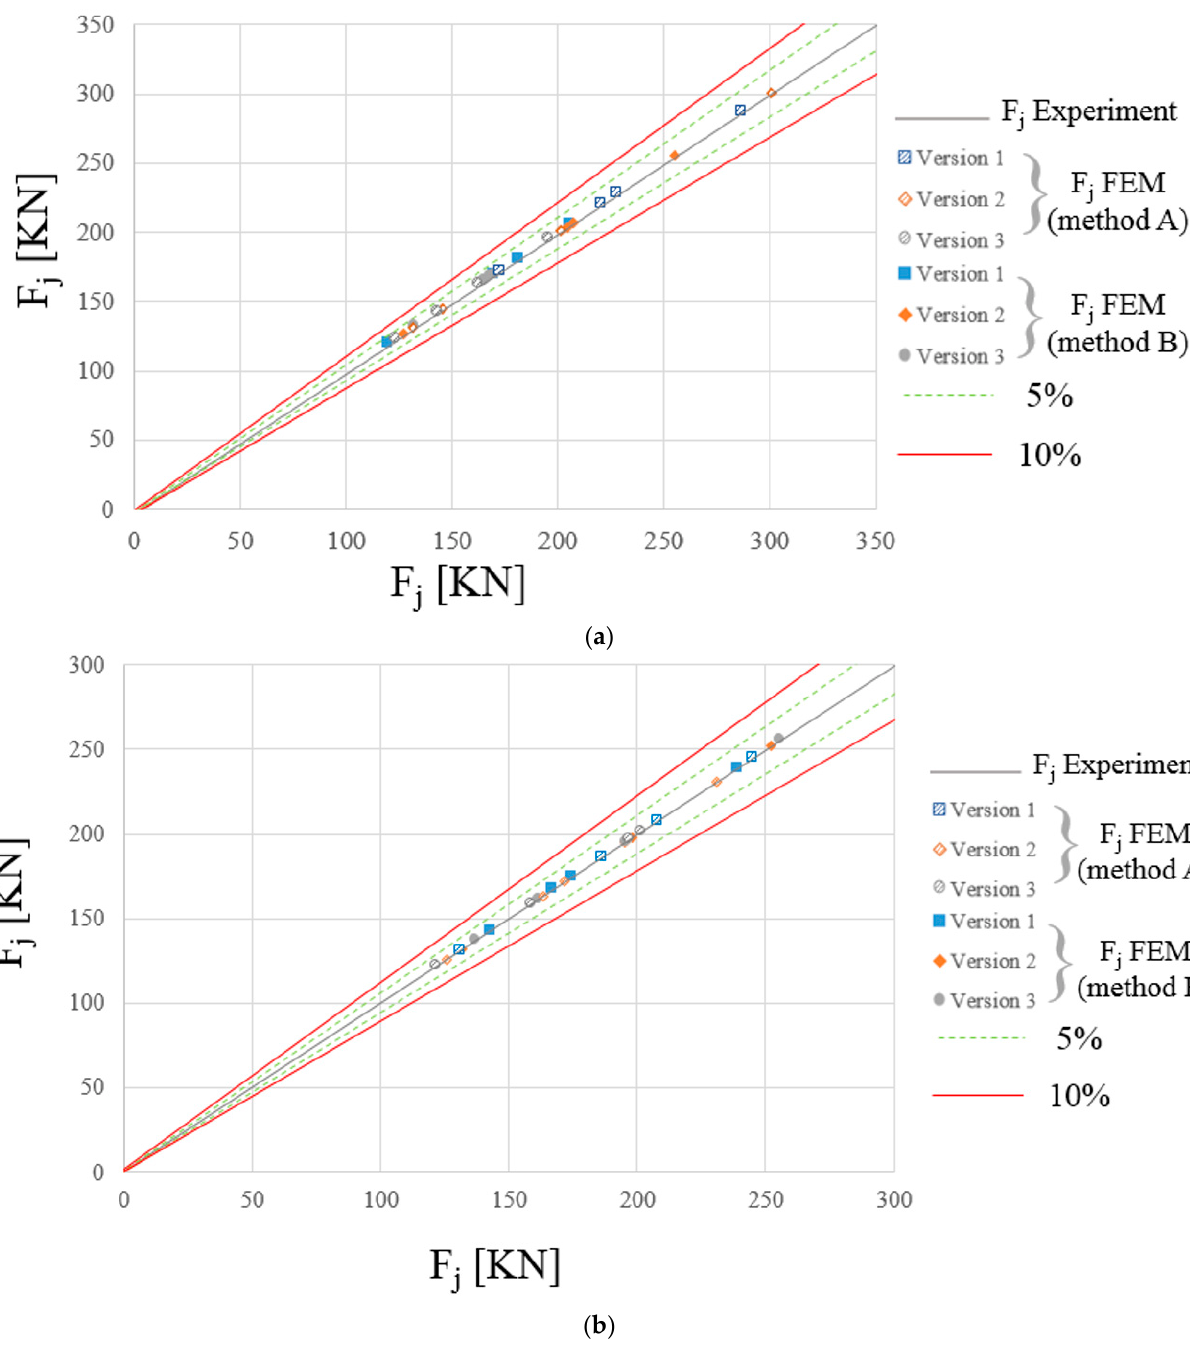
Figure 8. Comparison of the experimental and numerical forming process results with different hub thicknesses: ( a ) 10 mm and ( b ) 15 mm. Comparison of the jointing force between the experiment and simulation with hub thicknesses of 15 mm is shown in Figure 8b. The experimental force values are shown at the horizontal and the vertical axis as an inclined line in gray color. The values of the numerical computations are recorded on the y -axis of the diagram in Figure 8a,b, which show